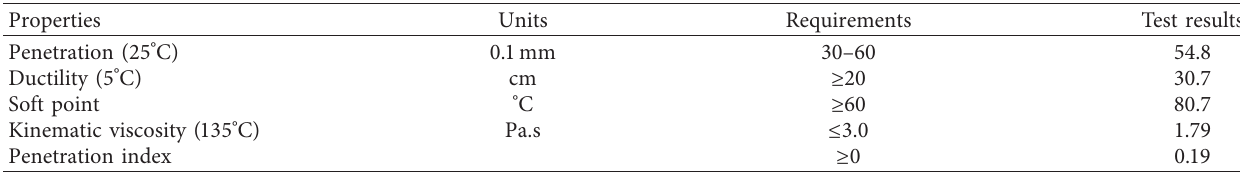
Figure 1: Aggregate gradation of OGFC. Table 1: Properties of SBS binder.